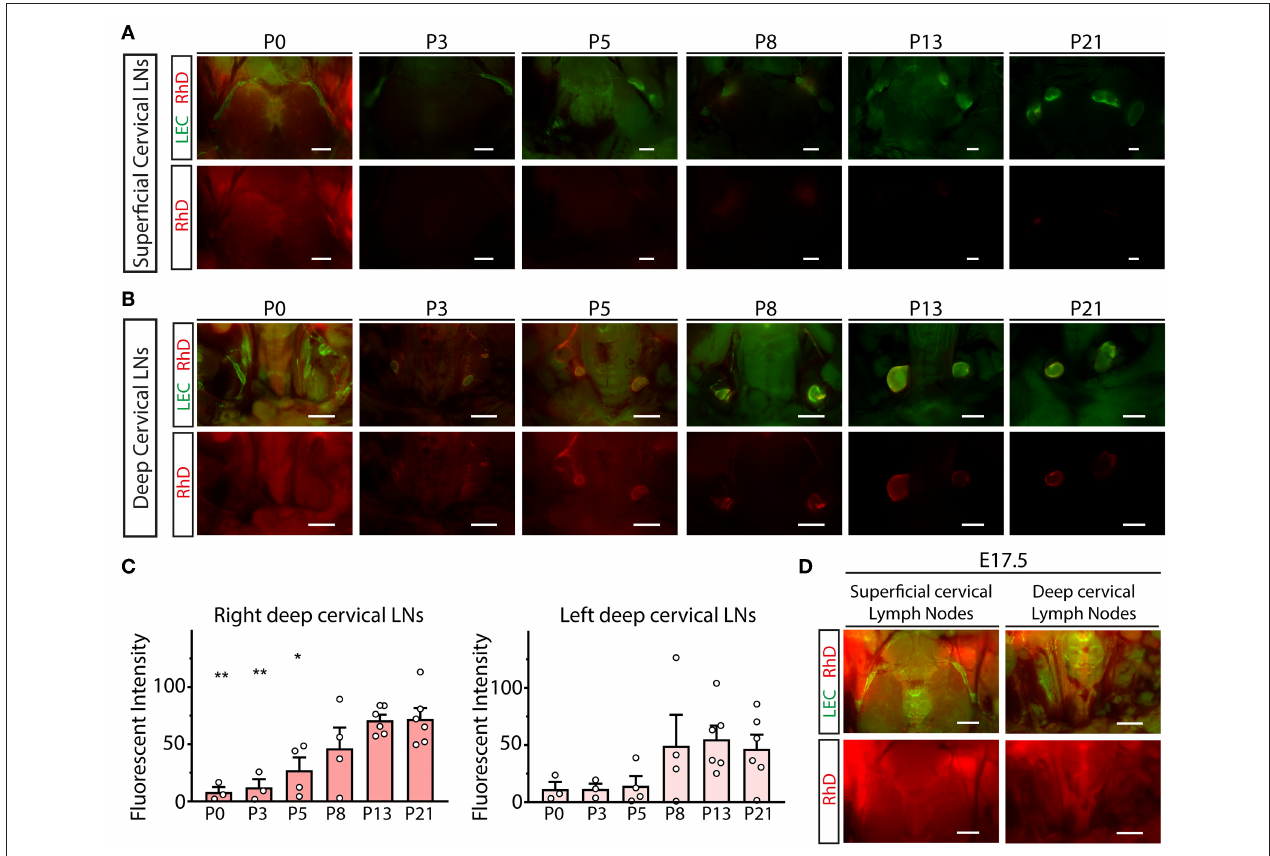
FIGURE 5 | Monitoring the drainage of macromolecules from the CNS during the first three postnatal weeks. (A,B) Drainage of 70 kDa RhD into the superficial cervical lymph nodes (A) and deep cervical lymph nodes (B) of lymphatic reporter mice at P0, P3, P5, P8, P13 and P21 after intraparenchymal injection (P0 n = 3; P3 n = 3; P5 n = 4; P8 n = 4; P13 n = 6; P21 n = 6). Bars, 1,000 µ m. (C) Quantitative data for mean fluorescent intensity in the deep cervical lymph nodes (mean fluorescent intensity of background subtracted from the mean fluorescent intensity of lymph nodes) after intraparenchymal injection of 70 kDa RhD into lymphatic reporter animals at P0, P3, P5, P8, P13 and P21 (One-way ANOVA, Dunnett’s post-hoc test; mean ± SEM; n = 3 or more animals for each group; P0 n = 3; P3 n = 3; P5 n = 4; P8 n = 4; P13 n = 6; P21 n = 6; * P < 0.05 vs. P21; ** P < 0.01 vs. P21). (D) Drainage of 70 kDa RhD into the superficial and deep cervical lymph nodes of Flt4 YFP reporter mice at E17.5 after in utero intraparenchymal injection ( n = 2). Bars, 1,000 µ m. Representative images are